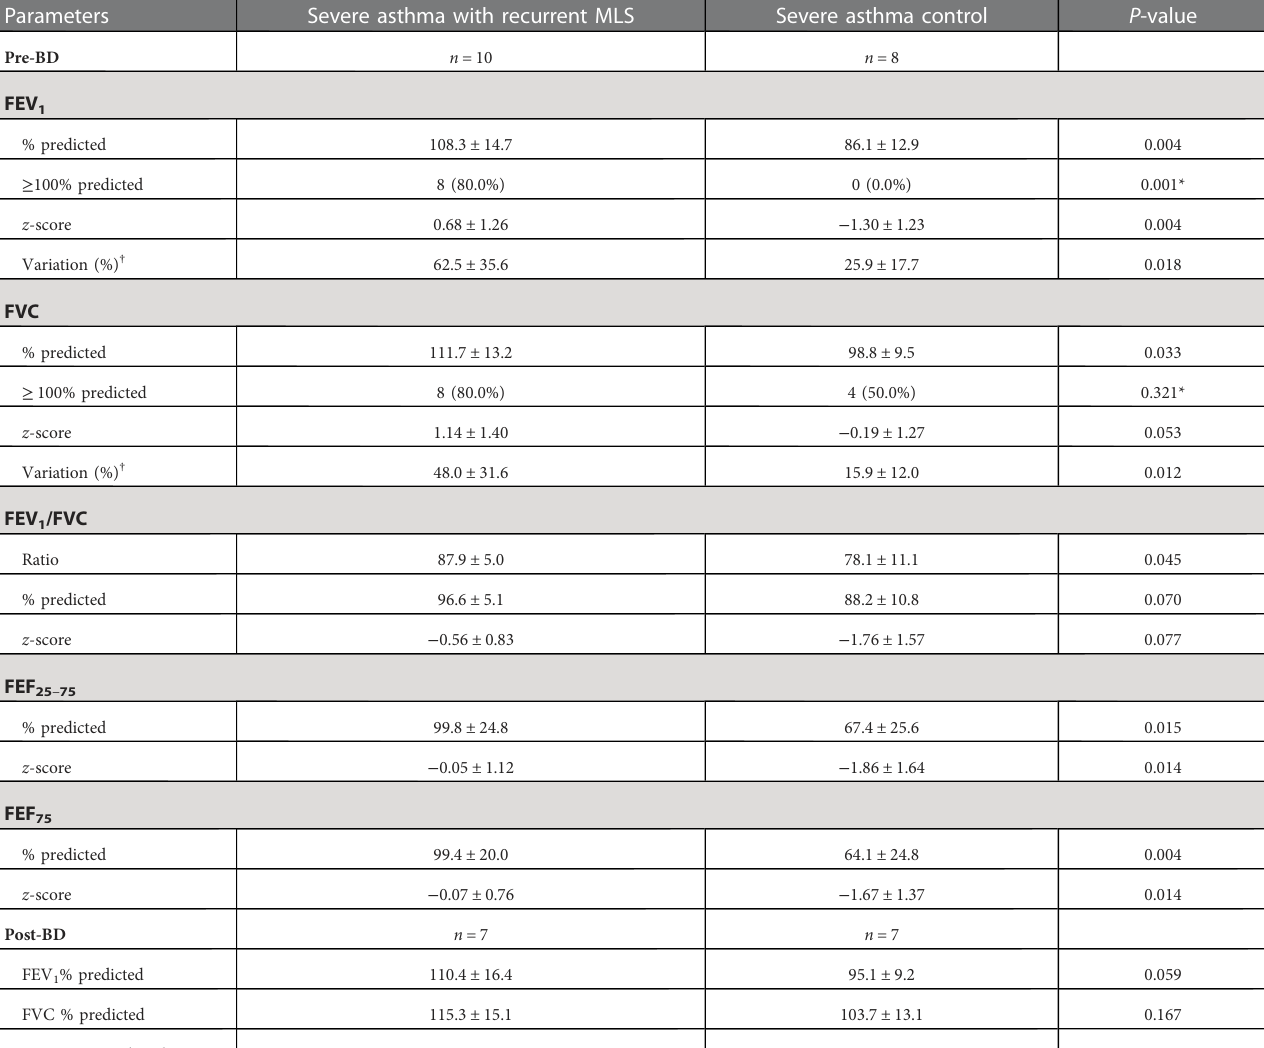
TABLE 6 Spirometry of children with severe asthma strati fi ed by recurrent MLS.